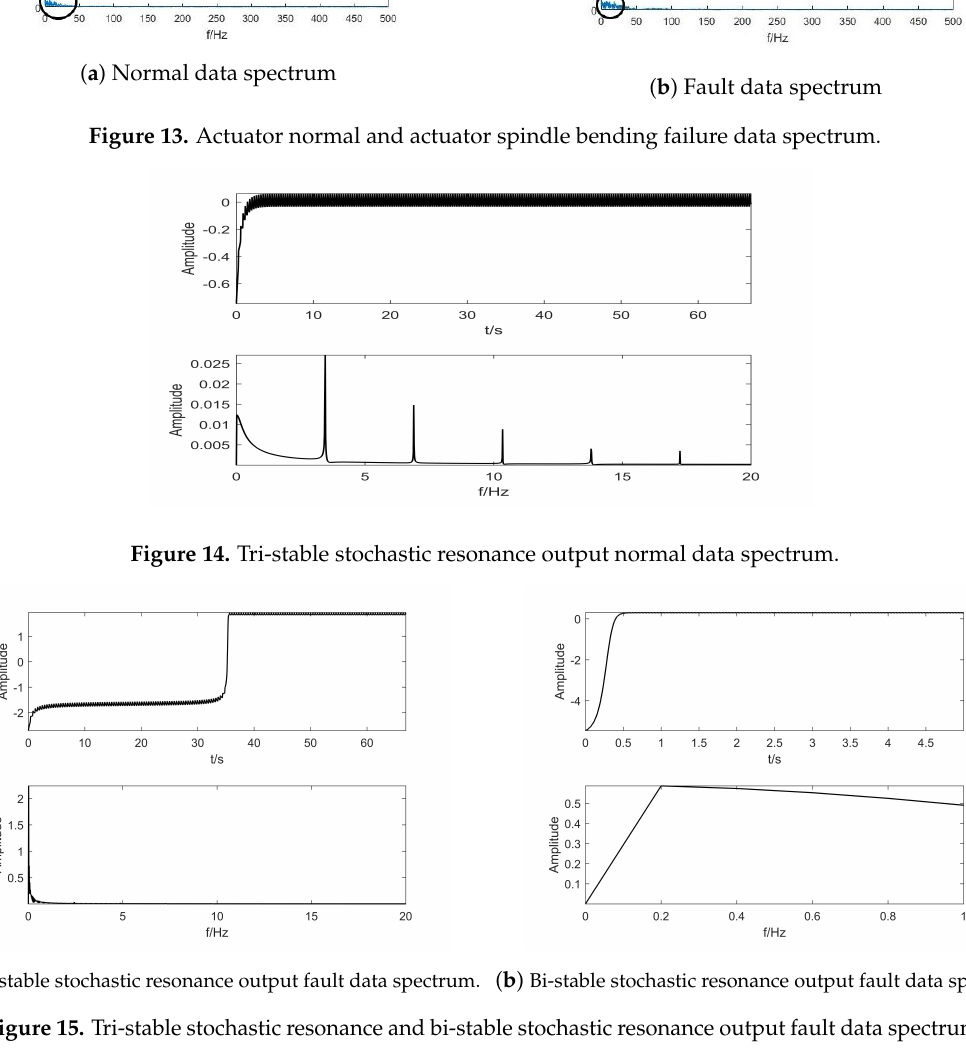
Figure 15. Tri-stable stochastic resonance and bi-stable stochastic resonance output fault data